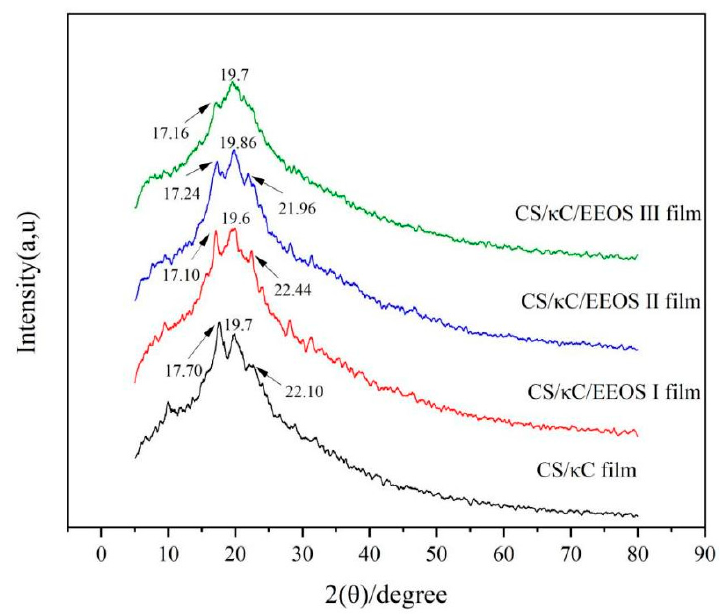
Figure 2. XRD spectra of CS/ к C, CS/ к C/EEOS I, CS/ к C/EEOS II, and CS/ к C/EEOS III composite films.